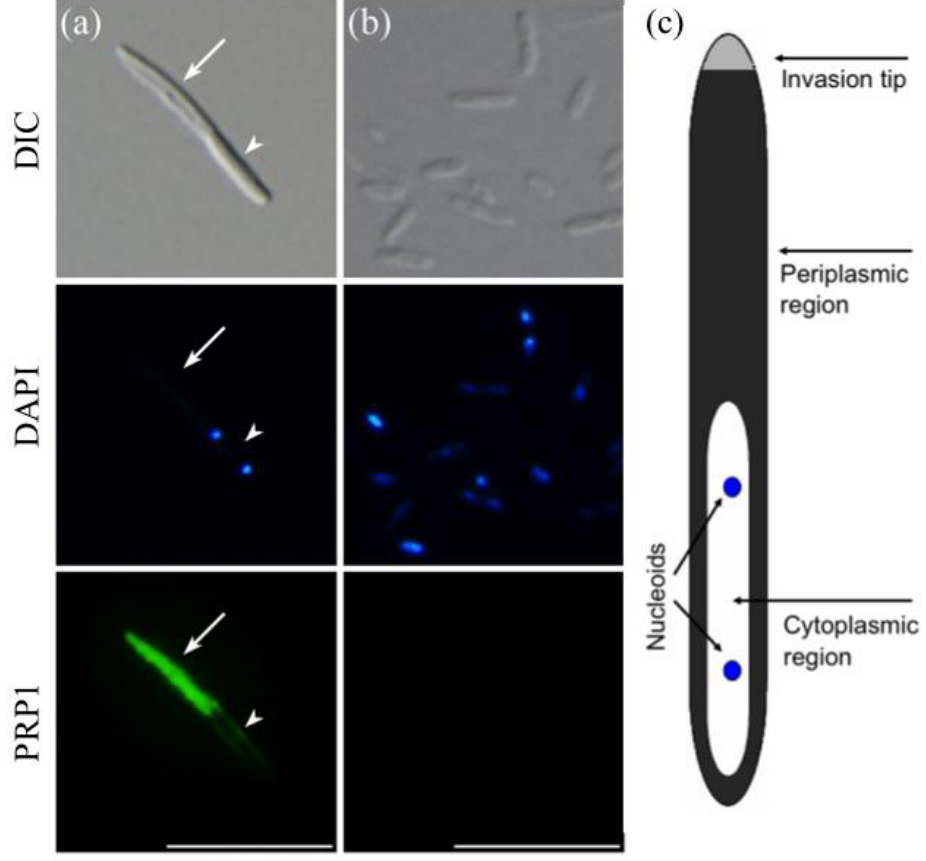
Figure 1. Indirect immunofluorescence micrographs of H. obtusa with monoclonal antibodies mAb3D1B9C4 specific for the 63-kDa periplasmic protein PRP1. Left ( a ), IF; middle ( b ), RFs; right ( c ), a schematic representation of the IF of H. obtusa. Upper photos, differential interference contrast (DIC); middle photos, DAPI fluorescence; lower photos, AF488 immunofluorescence. Only a periplasmic region (arrow) except an invasion tip of the IF shows immunofluorescence. Because the cytoplasmic region of the IF is covered with a thin layer of the periplasm, a faint immunofluorescence layer appears around the cytoplasmic region. A cytoplasmic region (arrowhead) with two DAPI-positive nucleoids shows no immunofluorescence. H. obtusa cells on cover glasses and were permeabilized with 20 mM NaOH to allow antibodies entry inside the outer membrane. The RF shows no immunofluorescence. Scale bar, 10 µm. Abamo et al. [25] reported that the PRP1 of the IFs was secreted into the host macronu- cleus at or later than 3 h after invasion of H. obtusa into the macronucleus. To confirm whether